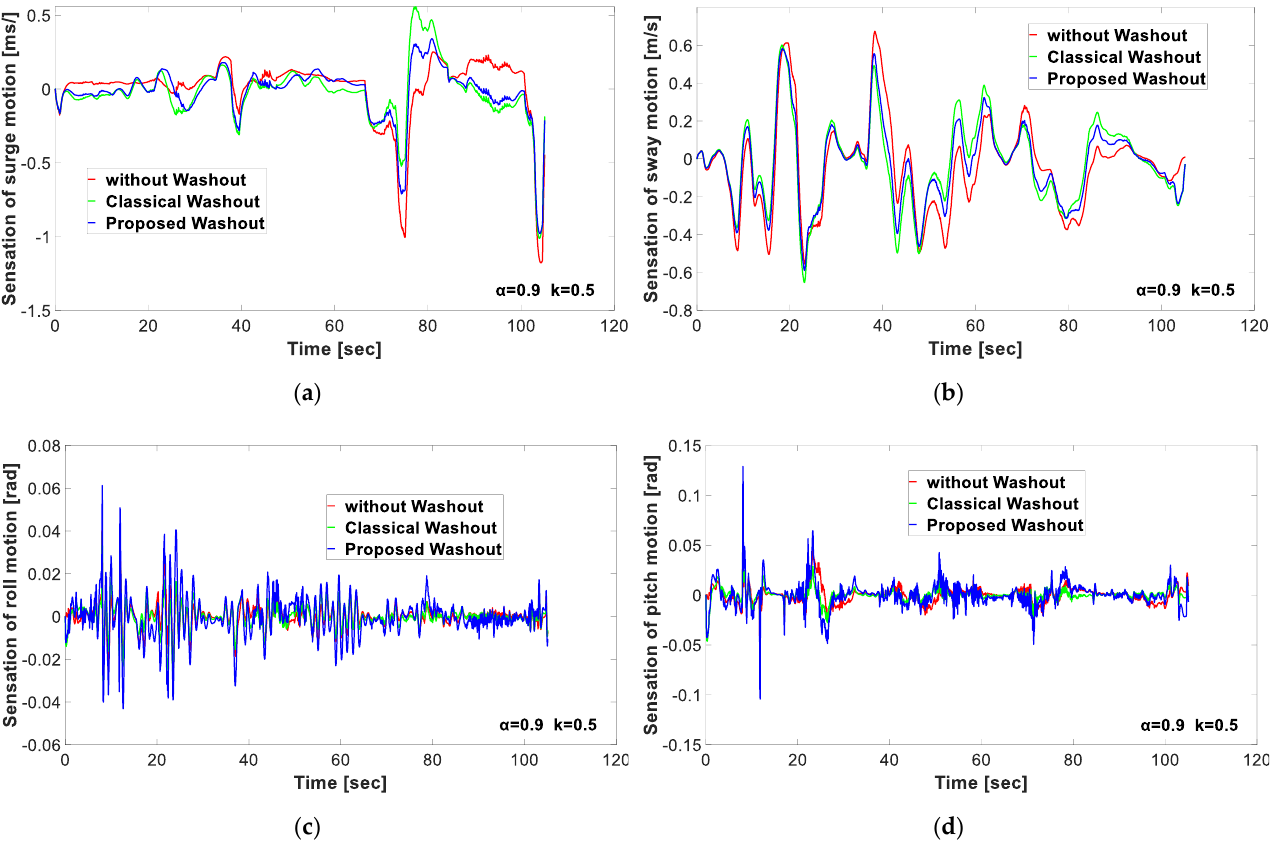
Figure 16. Motion sensation in the case of slope road (uphill/downhill) driving. ( a ) Motion sensation of surge direction. ( b ) Motion sensation of sway direction. ( c ) Motion sensation of surge direction. ( d ) Motion sensation of sway direction.